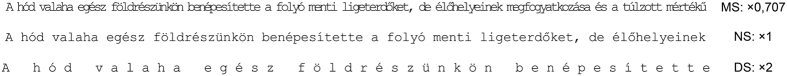
Sample visual stimuli used to reveal the effects of letter spacing on brain activity during natural reading.Hungarian paragraphs were presented line-by-line and subjects were instructed to read the text at their own pace from left to right. During the experiment eye-tracking and EEG data were recorded simultaneously to assess eye movement and brain activity correlates of letter spacing modulation. Three different levels of letter spacing were used: minimal spacing (MS, top row), normal spacing (NS, middle row) and double spacing (DS, bottom row). The size of inter-letter spacing for particular condition was obtained by multiplying the default letter spacing size with the multiplication factor denoted in the figure.